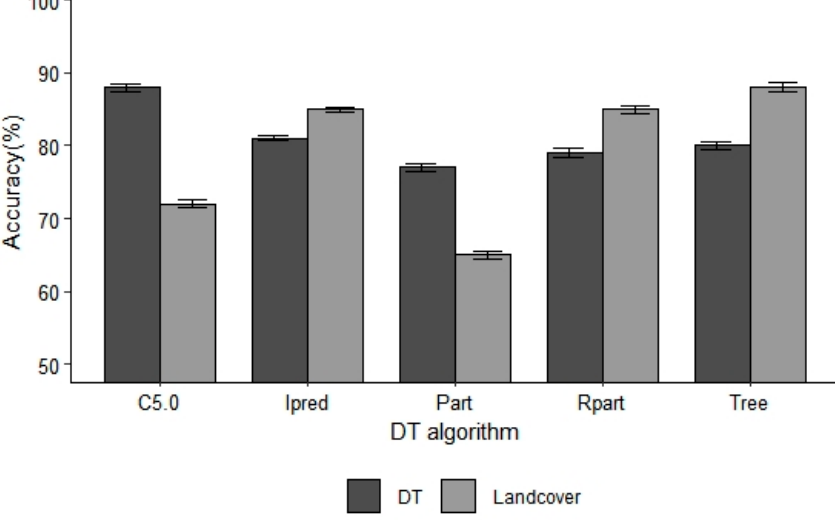
Figure 3. The mean DT accuracy of the five decision trees using from cross-validation.